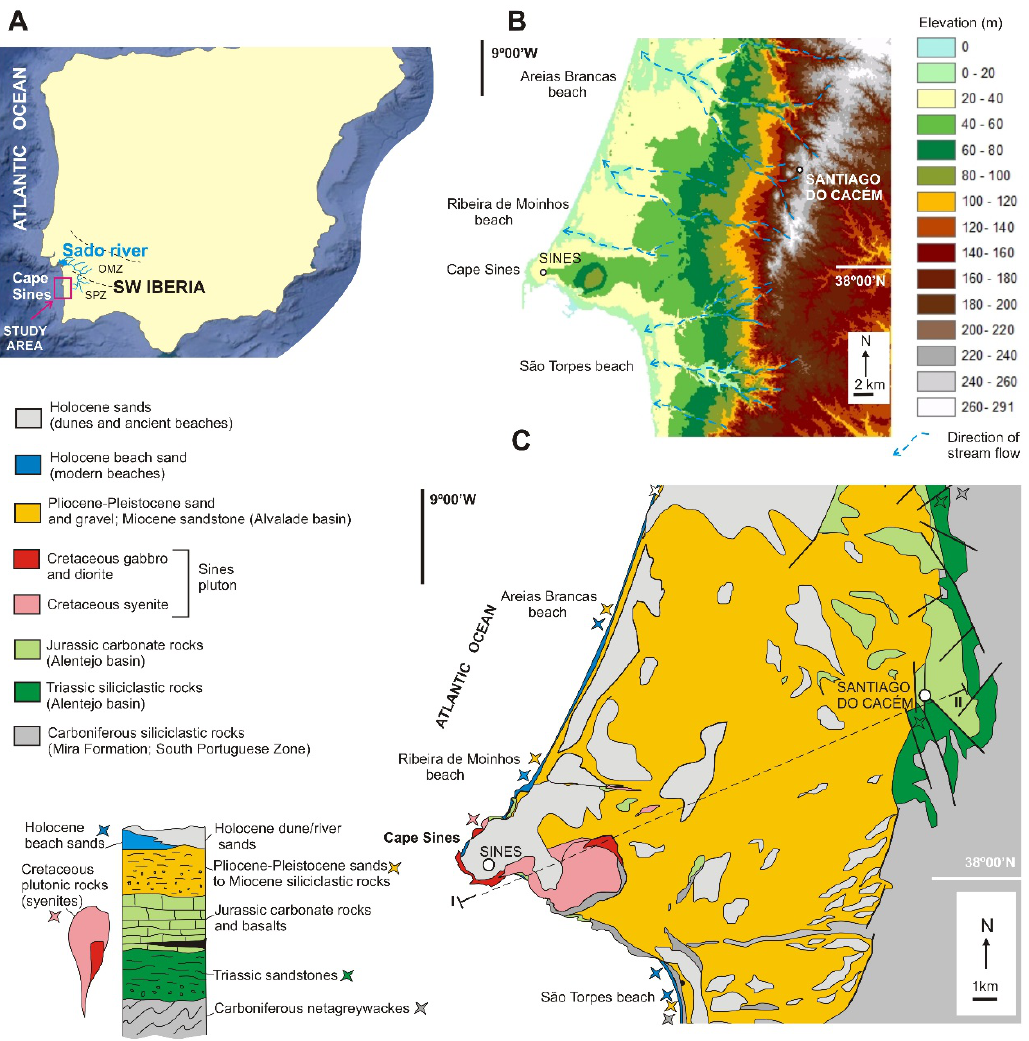
Figure 2. ( A ) Inset with the location of SW Iberia in a Google Earth Pro image of the Iberian Peninsula (western Europe) showing two tectonic units of the Variscan orogenic belt. OMZ = Ossa-Morena Zone, and SPZ = South Portuguese Zone, which includes the drainage system of the Sado River. ( B ) Digital elevation model based on high-resolution topographic data of the Shuttle Radar Topography Mission (SRTM-NASA), showing the relief and the drainage system (blue dashed lines) of the study area of Sines-Santiago do Cacém. ( C ) Simplified geological map and stratigraphy (the stars are units with U–Pb zircon data presented in Figures 3–5) of the Sines-Santiago do Cacém region, showing the Holocene sand de-